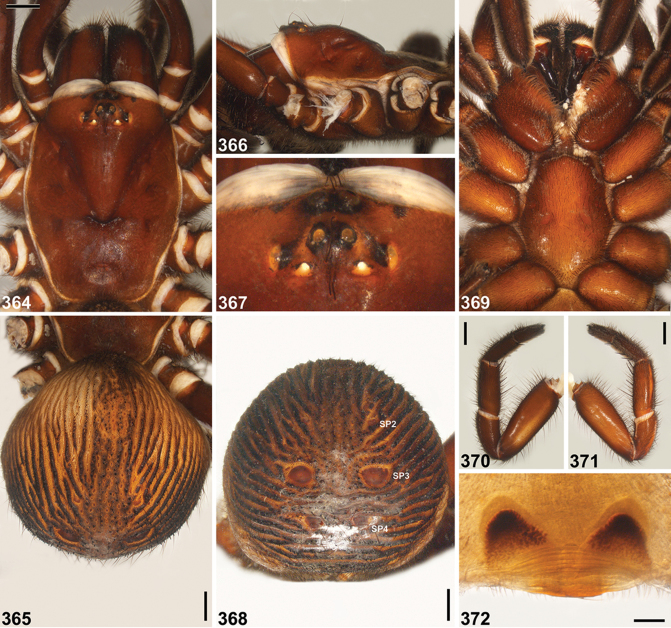

Idiosoma
sigillatum (O.P.-Cambridge, 1870), female (WAM T129191) from Karnup, Perth (Western Australia; SWA). 364–365 Carapace and abdomen, dorsal view 366 Carapace, lateral view 367 Eyes, dorsal view 368 Abdomen, posterior view 369 Sternum, ventral view 370 Leg I, prolateral view 371 Leg I, retrolateral view 372 Spermathecae, dorsal view. Scale bars 2.0 (364–365, 370–371), 0.5 (372). SP2–4 = sigilla pairs 2–4.